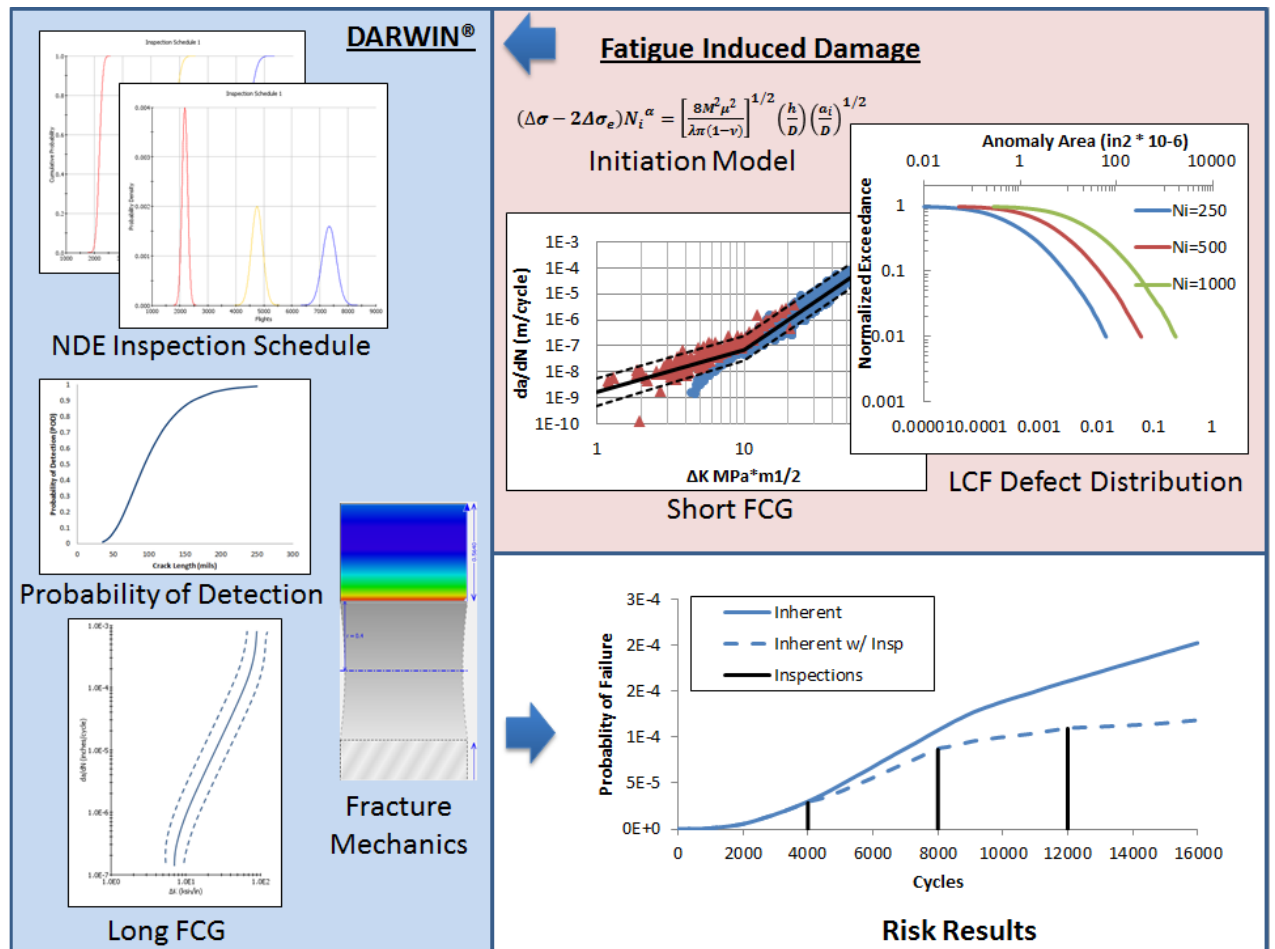
Figure 3. Input data sources in DARWIN to develop probabilistic framework.